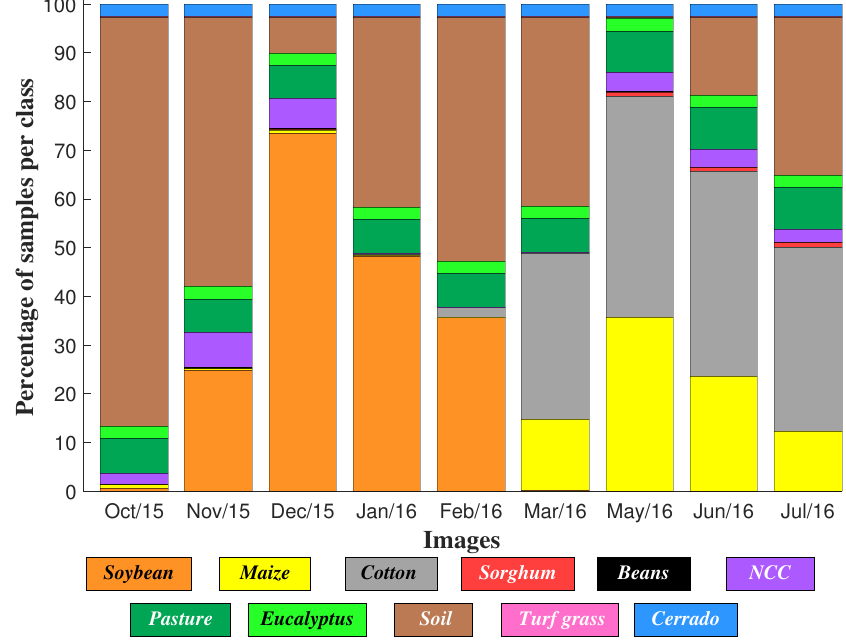
Figure 6. Class occurrences per month in Campo Verde. NCC, Non-Commercial